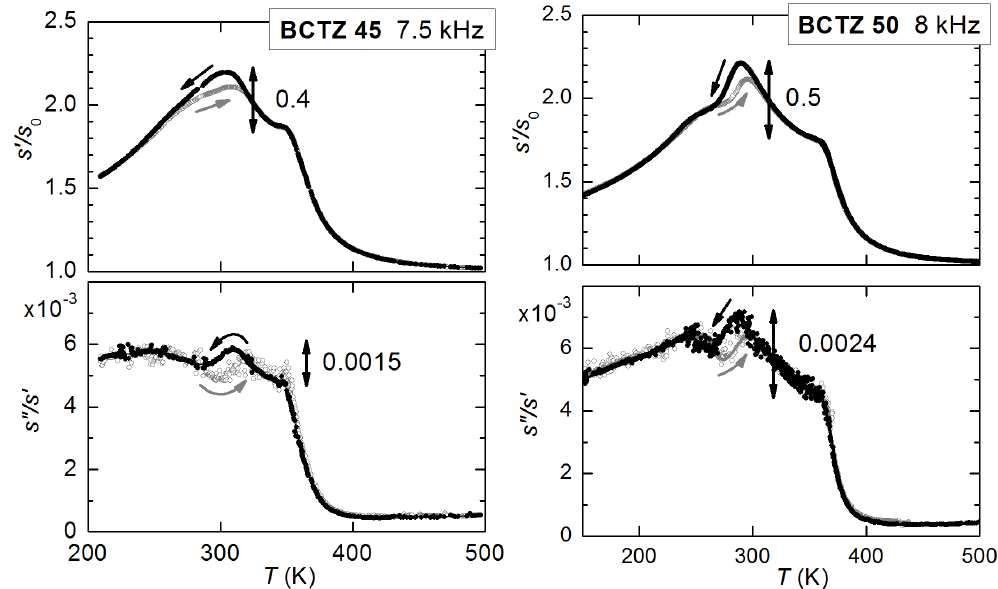
Figure 19. Elastic compliance and loss measured with the free resonance method in BCTZ − 45 and 50 during heating and cooling (data from [192]). The double arrows indicate the amplitudes of the total contributions of the O-R anomaly to the real part and